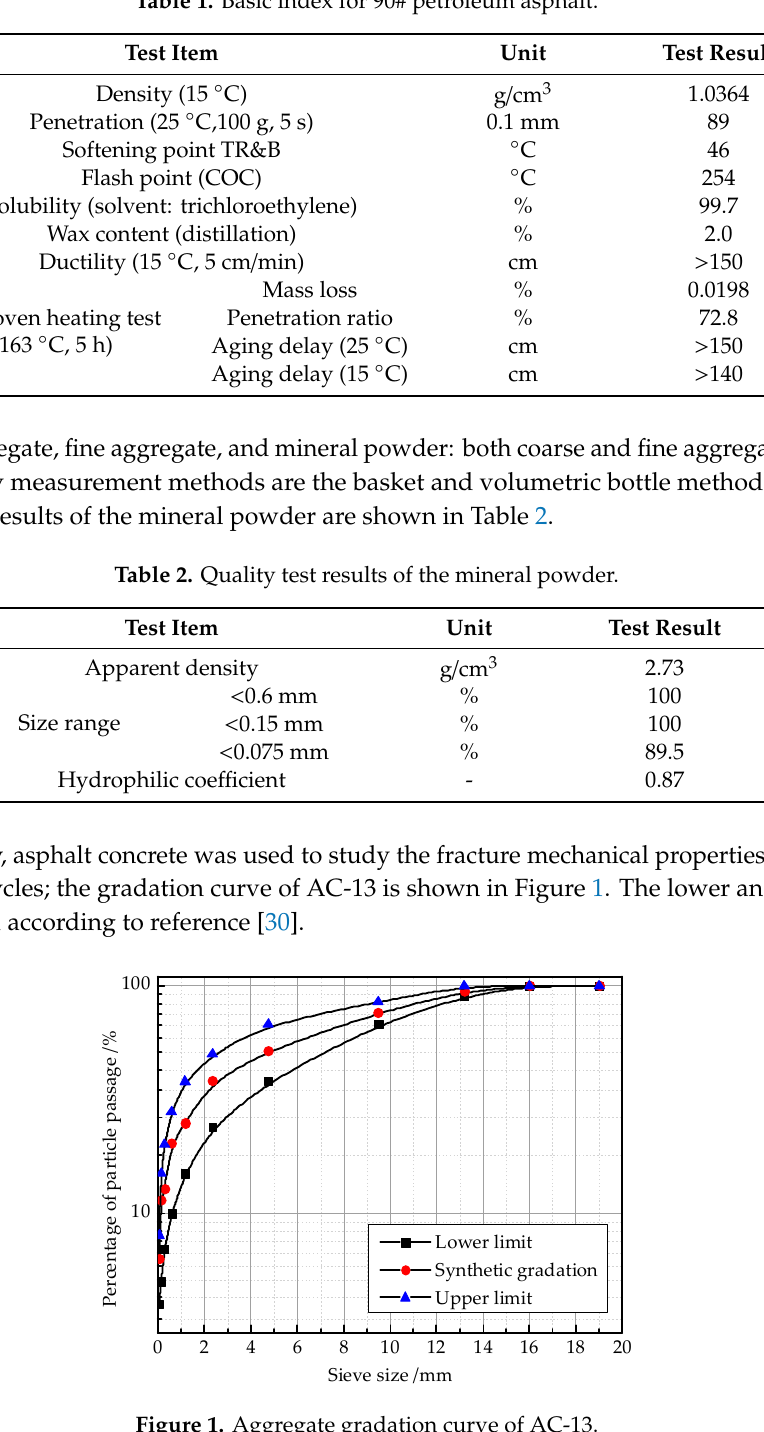
Table 1. Basic index for 90# petroleum asphalt.